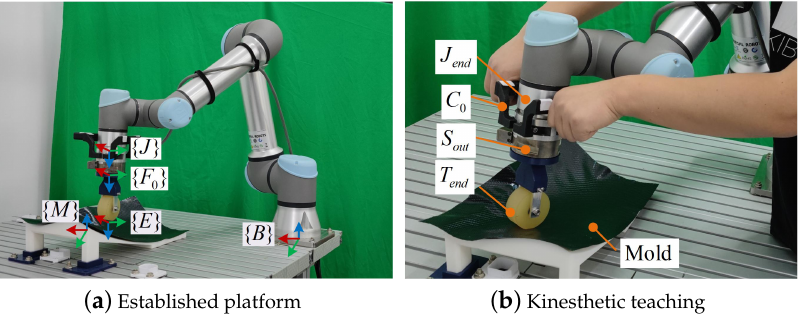
Figure 5. Platform of the contact task. The platform is built for the contact task of the composite woven layup. The human guides the robot for the contact task